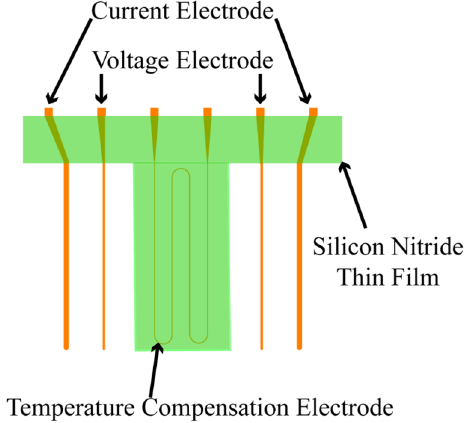
Figure 2. The figure is a schematic diagram of the chip structure. The dimensions of the electrodes were determined using COMSOL FEM simulations.